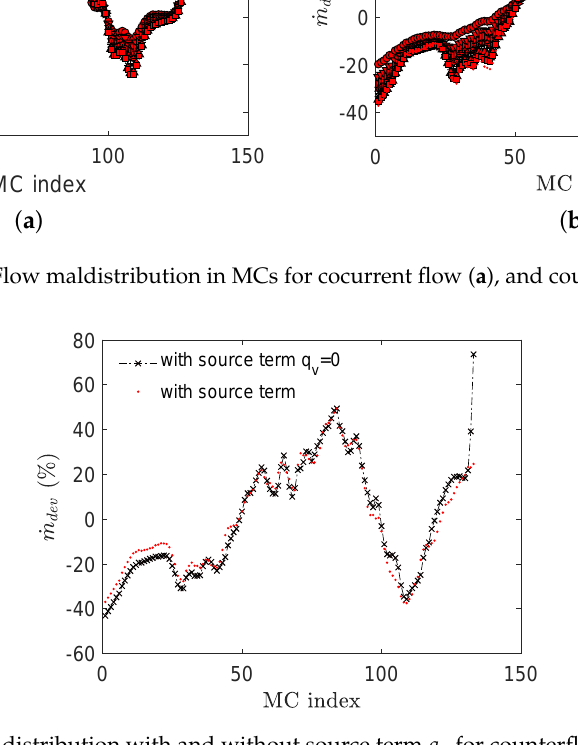
Figure 10. Flow maldistribution with and without source term q v for counterflow configuration with ˙ m f = 2.5